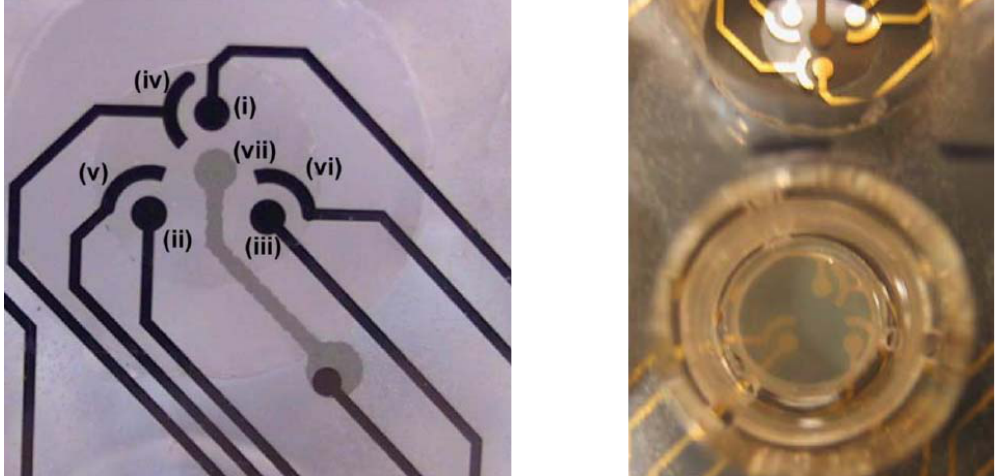
Figure 8. ( Left ) Representation of the array of electrode employed in this study: i, ii and iii are working electrodes; iv, v and vi are counter electrodes; and vii is the reference electrode. ( Right ) Photograph of the well plate with and without the membrane insert positioned over the integrated electrodes on the bottom